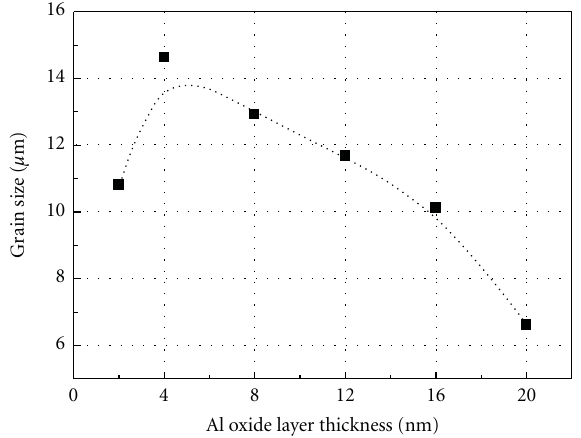
Figure 7: Average grain size extracted from EBSD data of the pc-Si films as a function of Al oxide layer thickness.